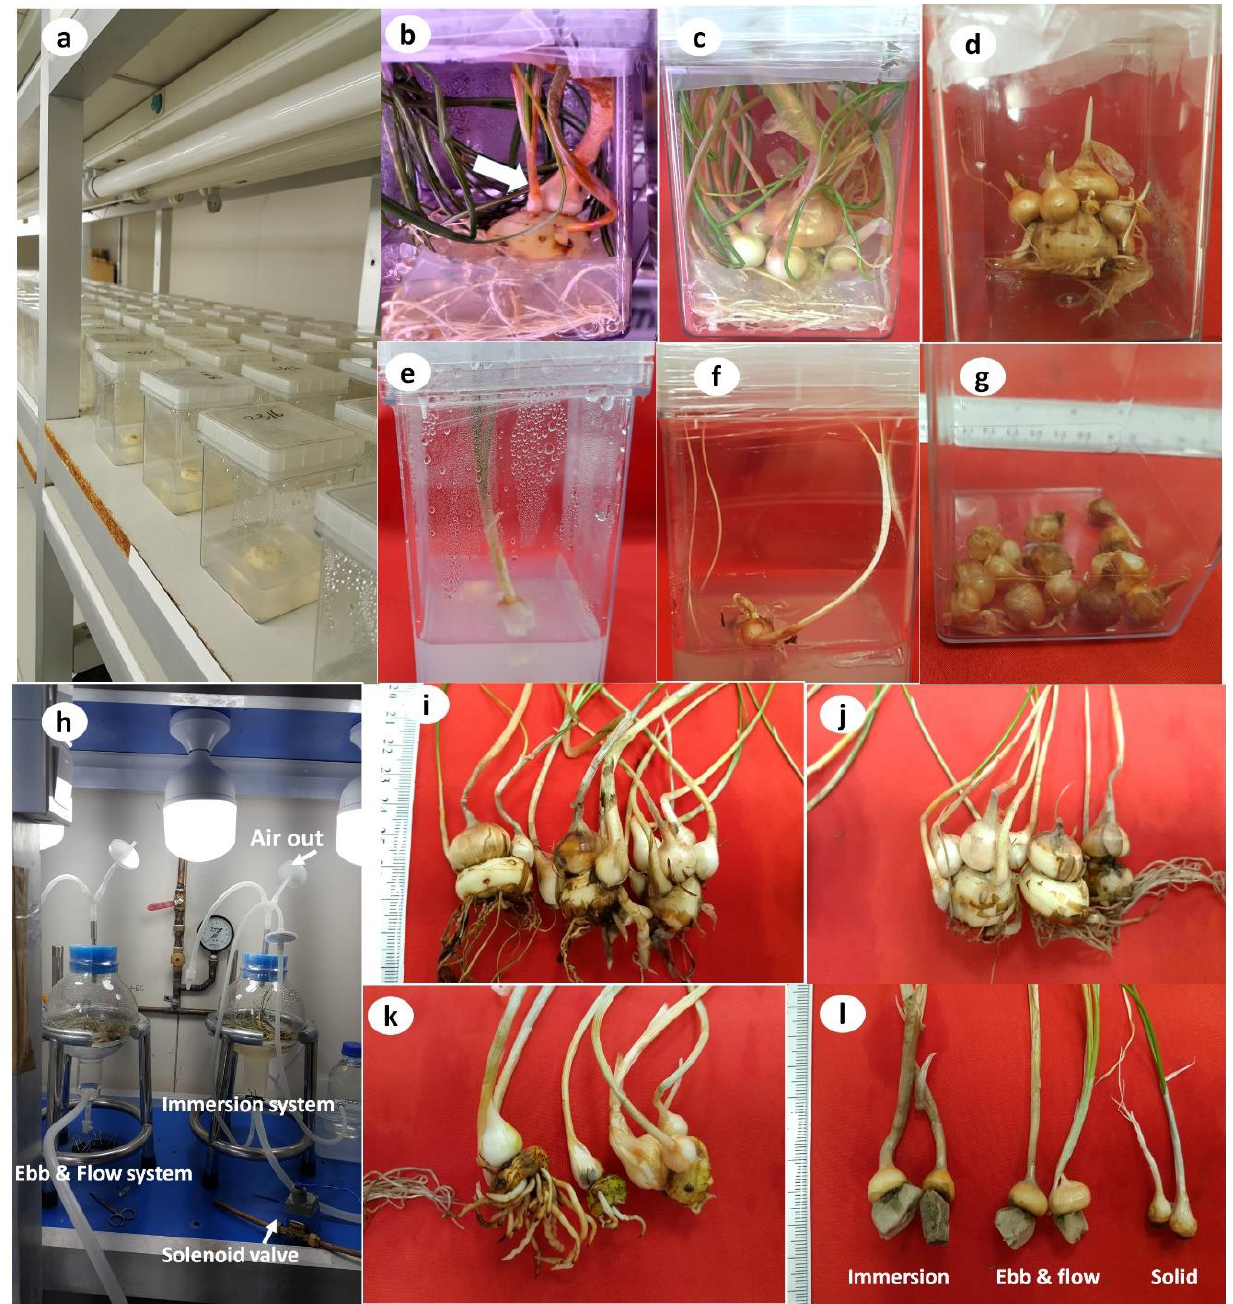
Figure 2. Effects of explant type (intact corms and apical buds) and culture system (solid culture, continuous immersion bioreactors, and ebb and flow bioreactors) on in-vitro-produced daughter saffron corm formation: ( a ) Established saffron aseptic culture; ( b – d ) Daughter corm formation following 10, 14, and 16 weeks, respectively, of solid culture using intact corm explants; ( e ) Bud break and shoot development of apical buds after 2 weeks of culture; ( f , g ) Daughter corm formation following 14 and 16 weeks, respectively, of solid culture using intact corm explants; ( h ) Layout of continuous immersion and ebb and flow bioreactors; ( i – k ) Daughter corm formation using intact corms in continuous immersion bioreactors, ebb and flow bioreactors, and solid culture, respectively, after 16 weeks of culture; ( l ) Daughter corm formation using apical buds in continuous immersion bioreactors, ebb and flow bioreactors, and solid culture, respectively, after 16 weeks of